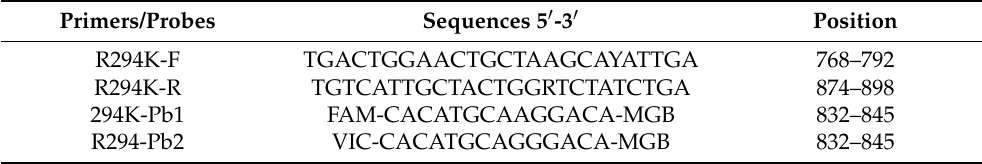
Table 1. Primer and probe sequences for the detection of the R294K mutation in H7N9